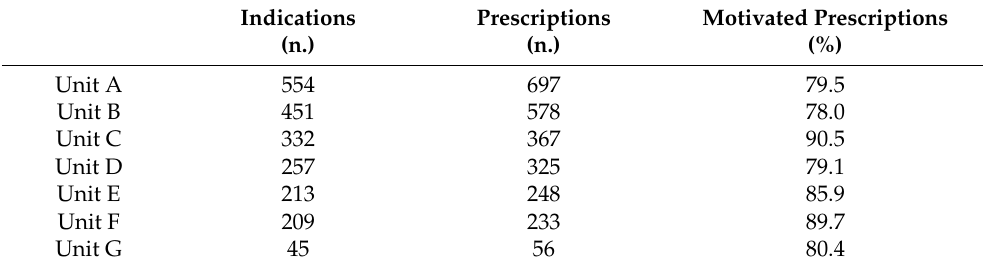
Table 3. Successful motivated antimicrobial prescription units—June–December 2021.